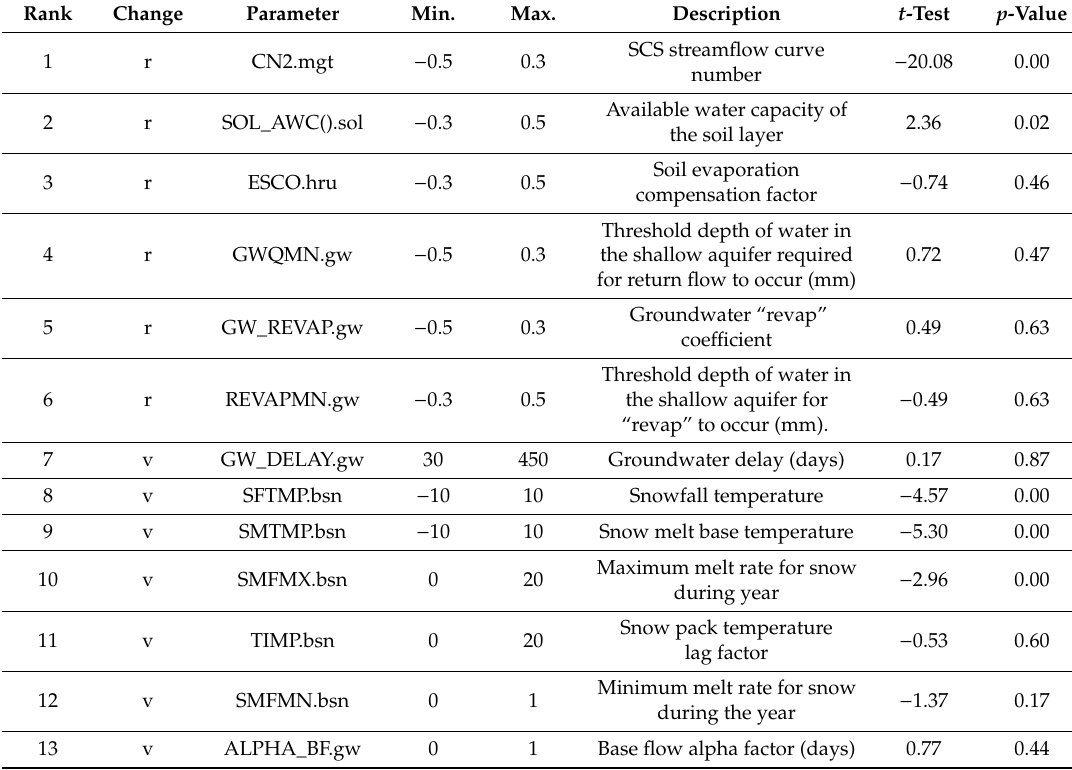
Table 2. Calibrated hydrologic parameters for the Derbendkhan Watershed.